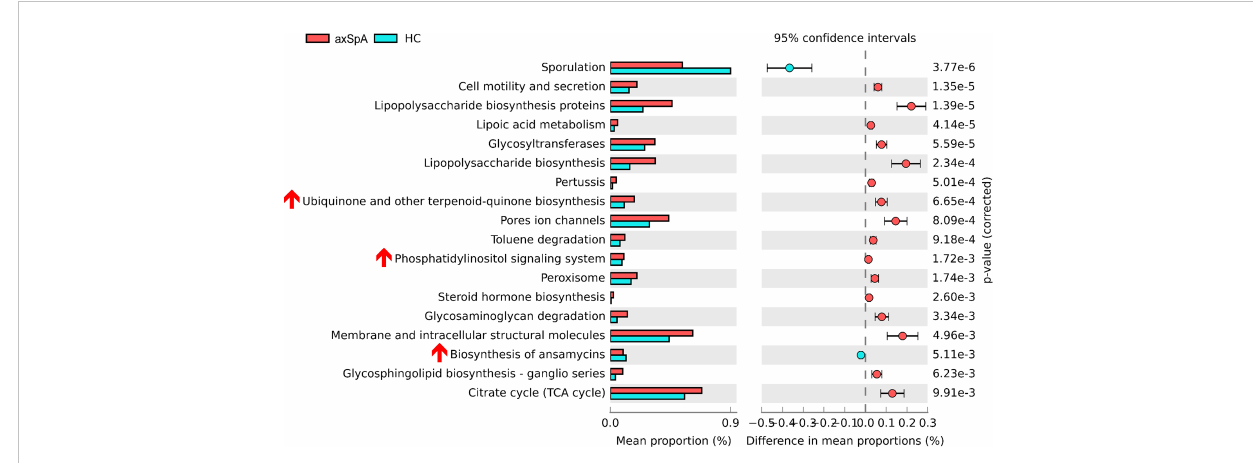
FIGURE 2 Microbial pathway analysis between axSpA patients and HCs. Functional pathway predictions with bacteria from axSpA patients and HCs. KEGG pathway analysis of OTUs enriched differentially between axSpA patients and HC microbiomes were analyzed using PICRUSt. P values are based on Welch ’ s test.